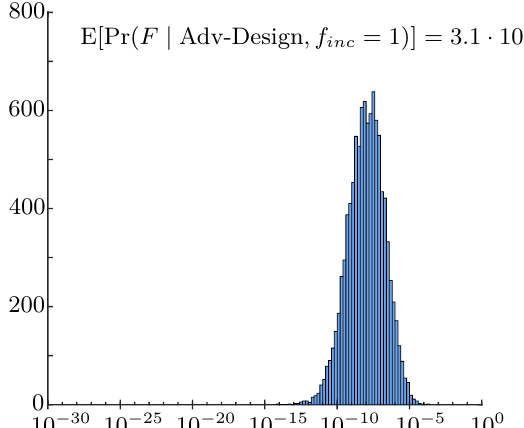
Figure 3. Histogram of the probability of failure Pr( F Adv-Design , f inc = 1) of bridge structures | designed following advanced traffic load modeling.